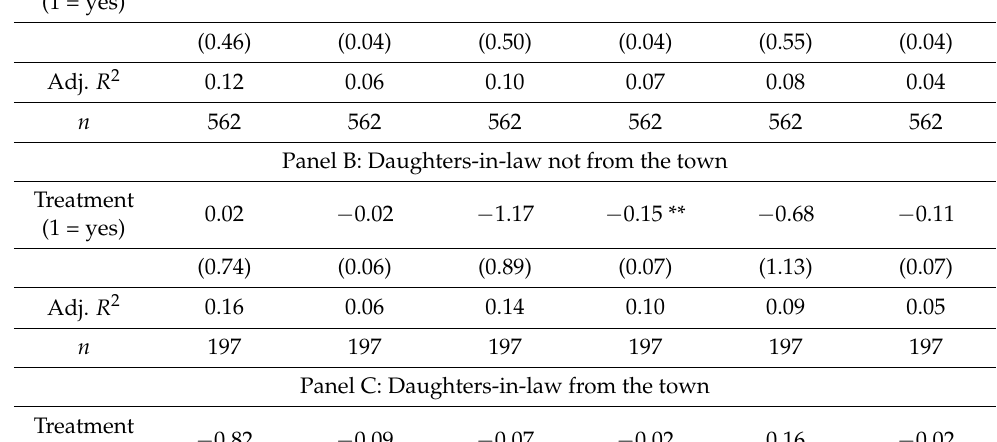
Panel A: Total sample of daughters-in-law